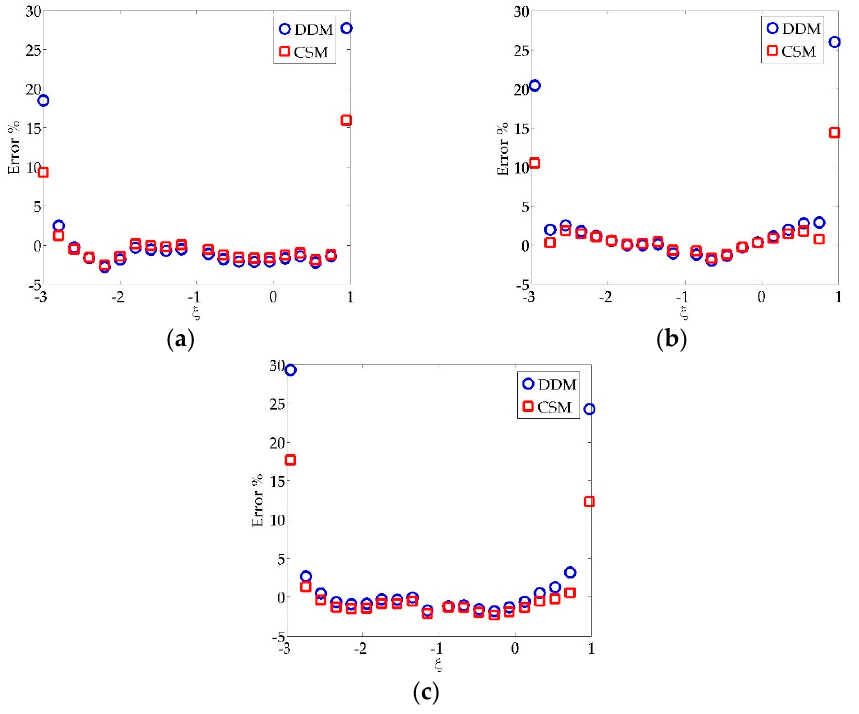
Figure 9. Percentage errors of the DDM and the CSM with b 1 / b 2 = ( a ) 1/25; ( b ) 1/1; and ( c ) 2/1.